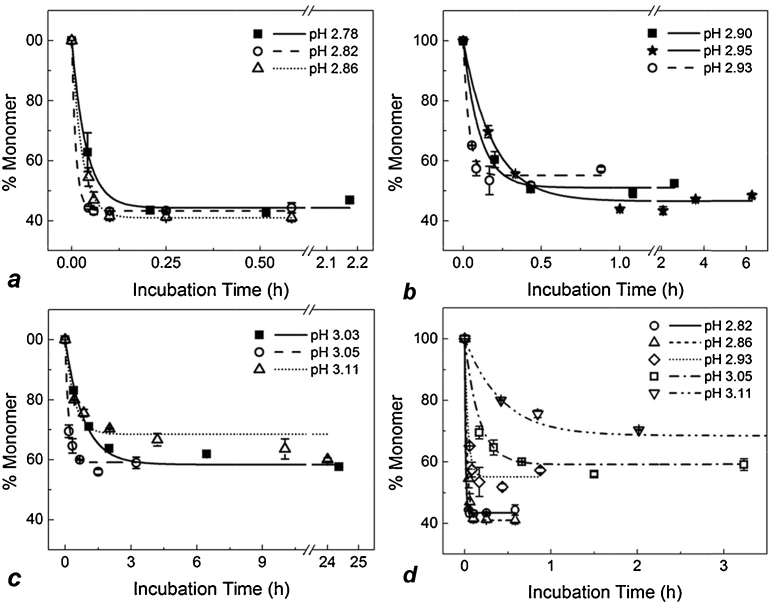
Rates of monomer loss at 2.7 mg/mL IgG under different pH conditions in solution only (filled symbols and solid lines) and after elution from a protein A chromatography column (open symbols, dashed lines and dotted lines) (a–c). Different pH conditions are shown in the plot legends. Curves for column runs across the full pH range are shown together in (d). Error bars show the standard deviation for each time point based on full experimental repeats, n = 2. All data sets were fitted with exponential decay curves as was done for initial solution only data. All fits were significant with adjusted r2 > 0.98 and P < 0.01.